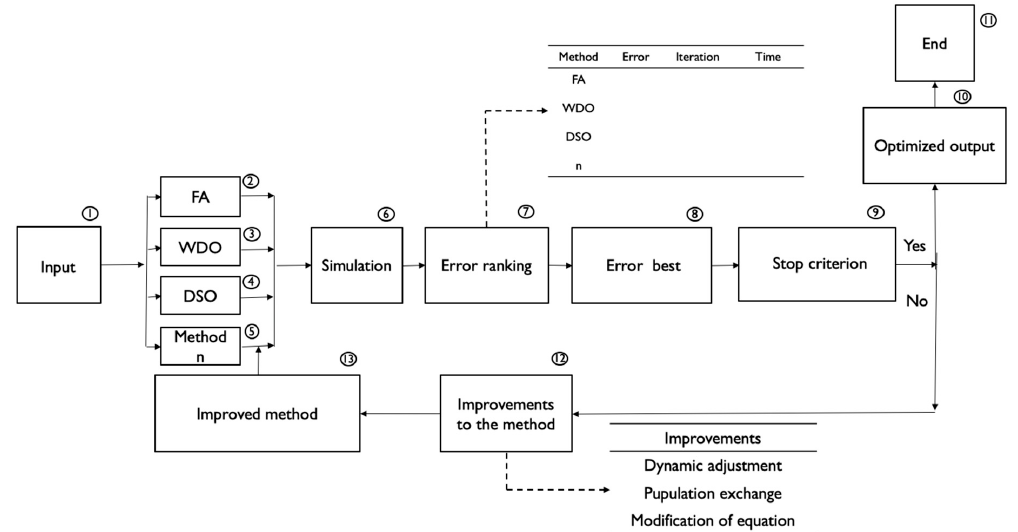
Figure 2. Data flow of the methodology.